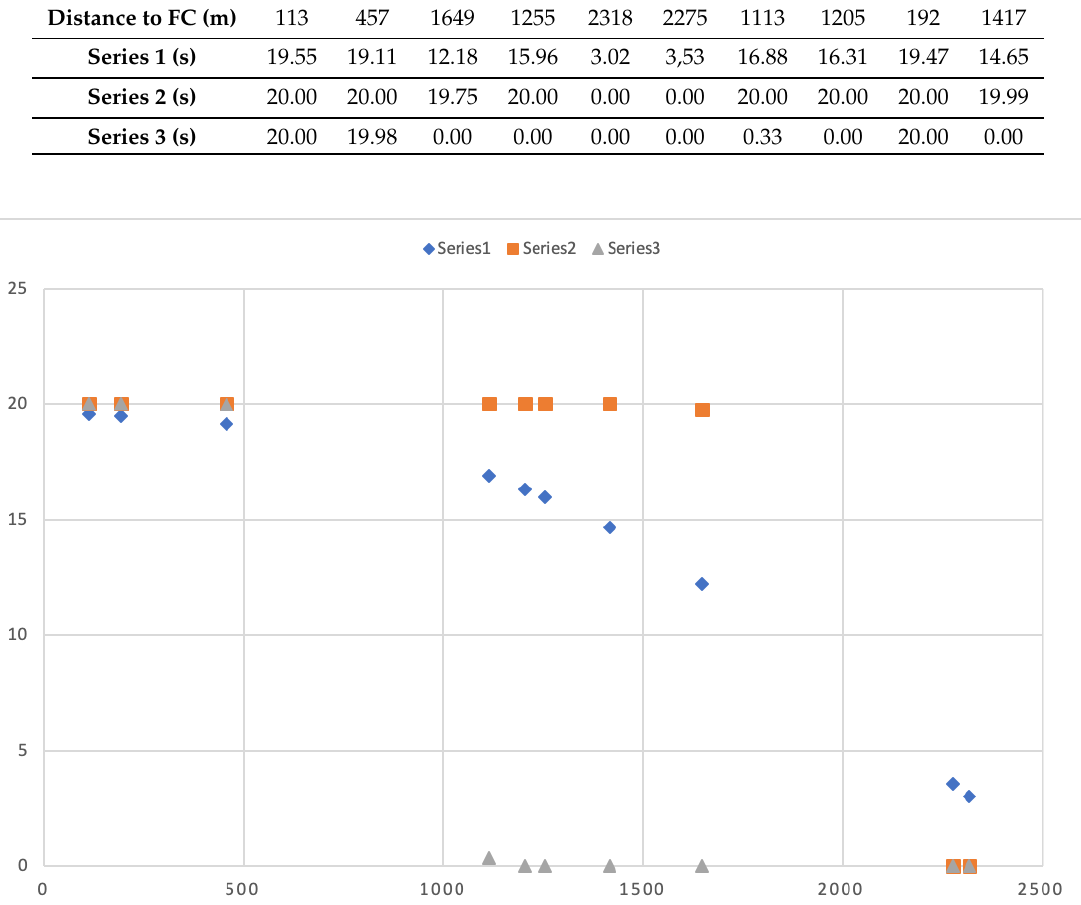
Figure 10. Delay function values for 10 randomly selected points with different distance to the